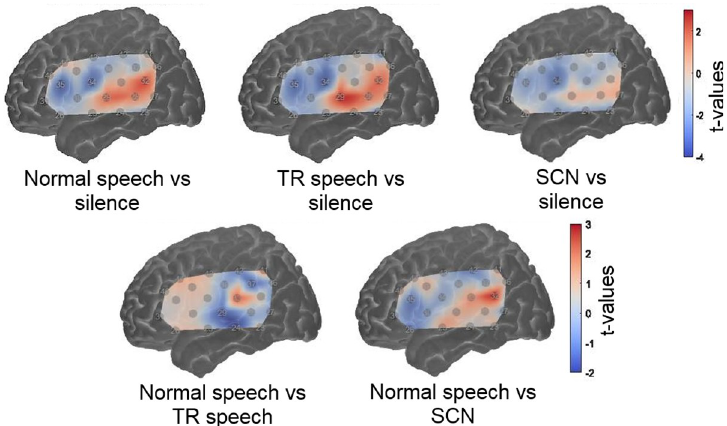
Fig 4. Group level cortical activation maps for each experimental contrast showing LH—RH activity. Results are shown projected on to the left hemisphere. Positive t -values indicate greater activity in LH channels compared to the corresponding channels in the RH. Negative t -values indicate that RH activity was greater. No channels showed a significant hemispheric difference ( q < .05, FDR corrected).